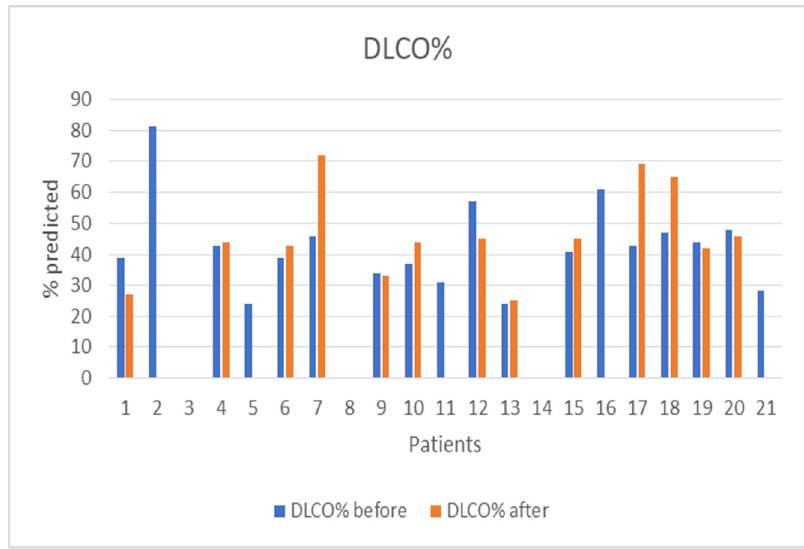
Figure 4. Patients’ DLco (% pred) before and after nintedanib treatment. Table 3. Patients’ diagnostic tests before and after nintedanib treatment.